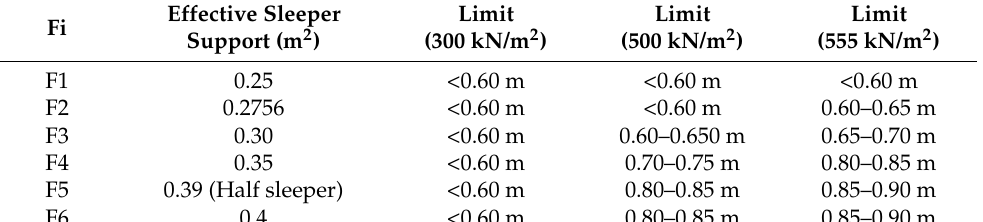
Table 8. Effective support area Fi considered of sleepers to calculate stress on ballast (Figure 12).